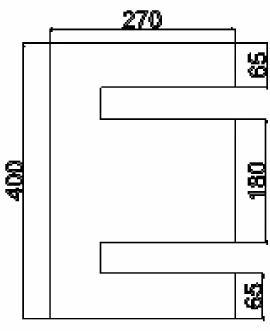
Figure 11. The layout of the push test set-up (dimensions are in mm).